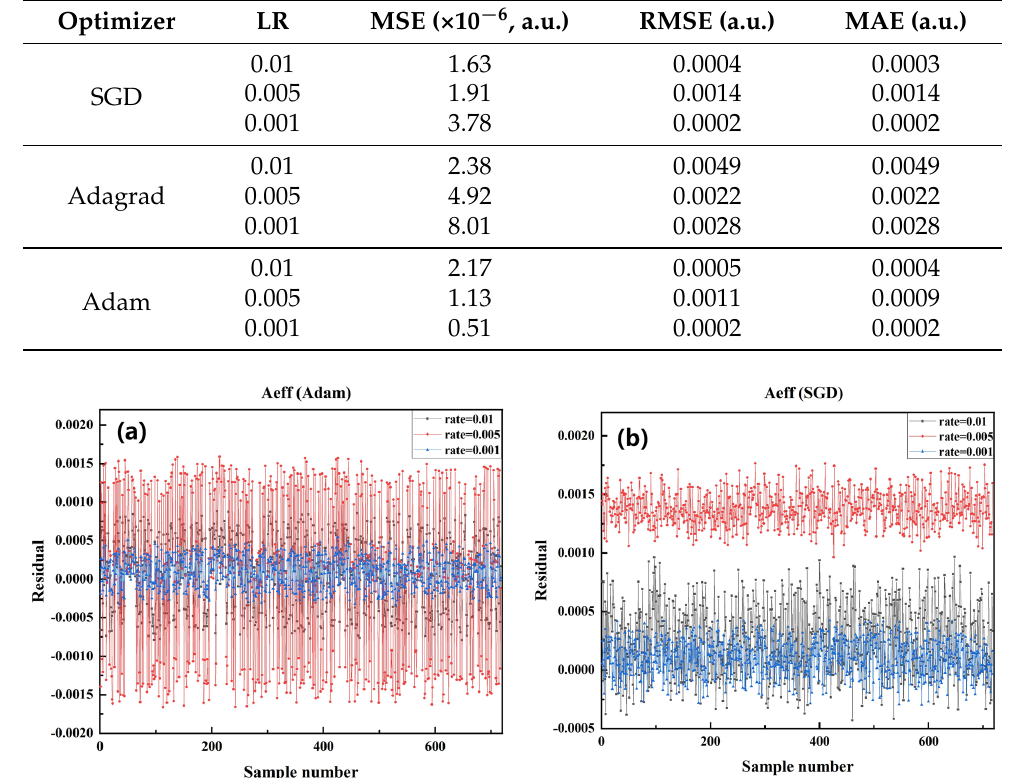
Table 2. Performance evaluation results for predictions of A ef f on the test dataset with models trained with different training configuration.